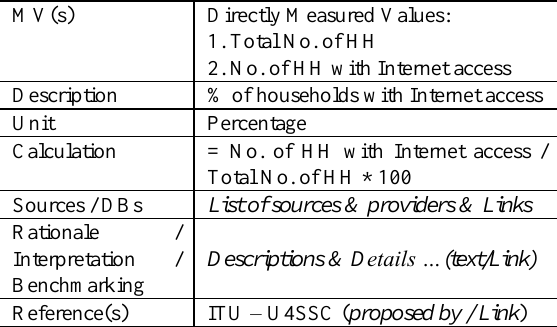
Table 1. Sample list of an indicator description and detailed